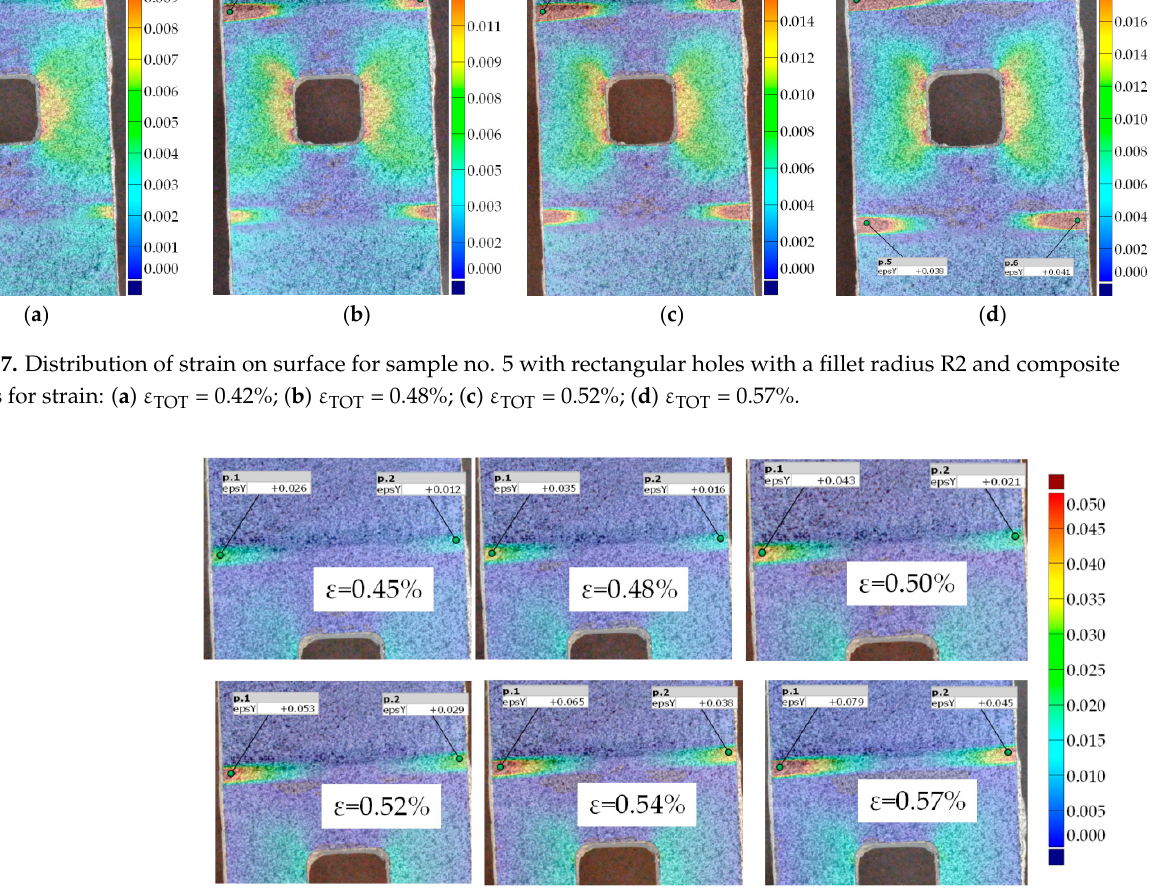
Figure 18. Development of strains and damage in adhesive joints for different ε TOT.